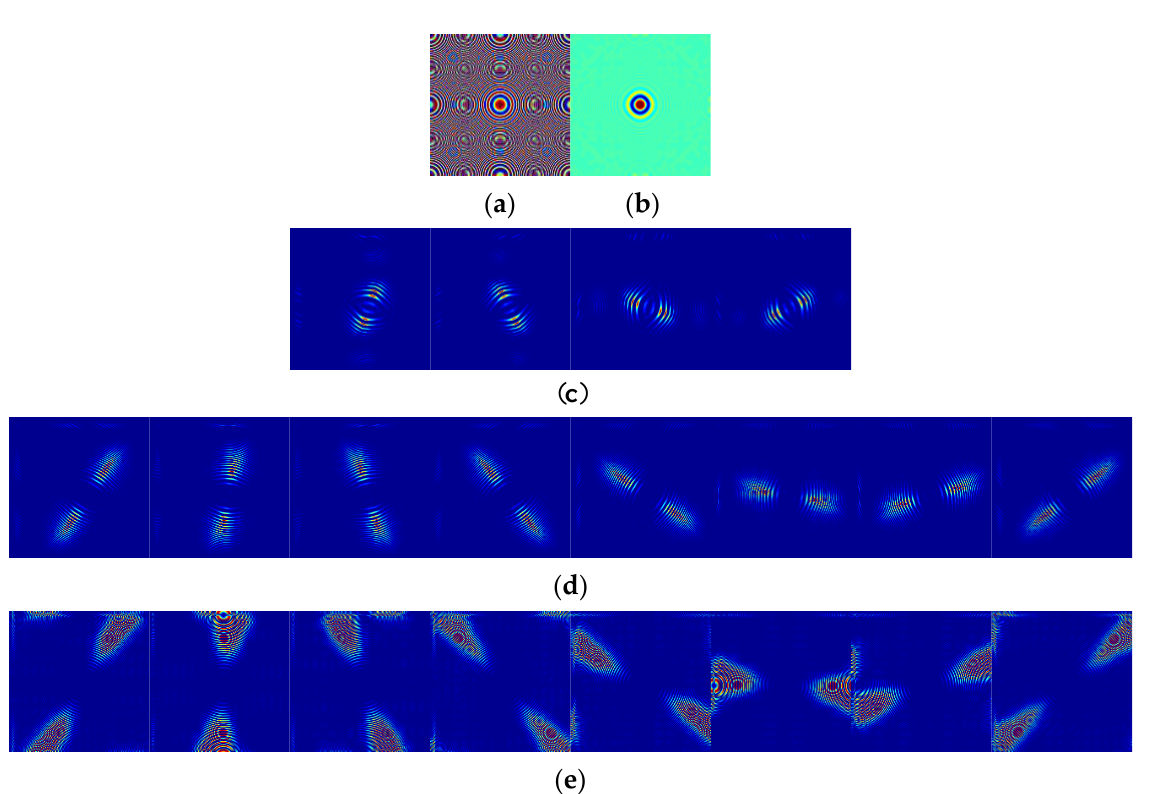
Figure 1. The nonsubsampled shearlet transform (NSST) decomposition of a zoneplate image. ( a ) original zoneplate image, ( b ) the low-frequency component, ( c ) the high-frequency sub-bands of NSST decomposition at level 1, ( d ) the high-frequency sub-bands of NSST decomposition at level 2, ( e ) the high-frequency sub-bands of NSST decomposition at level 3.